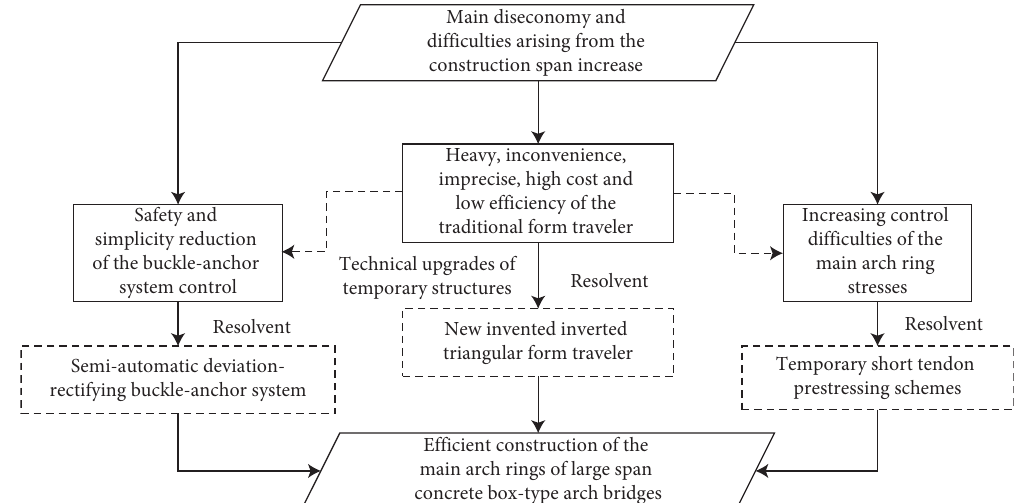
Figure 1: Adaptability design and control of temporary facilities for addressing the low efficiency issues of cantilever casting erection of mountainous concrete box-type arch bridges.